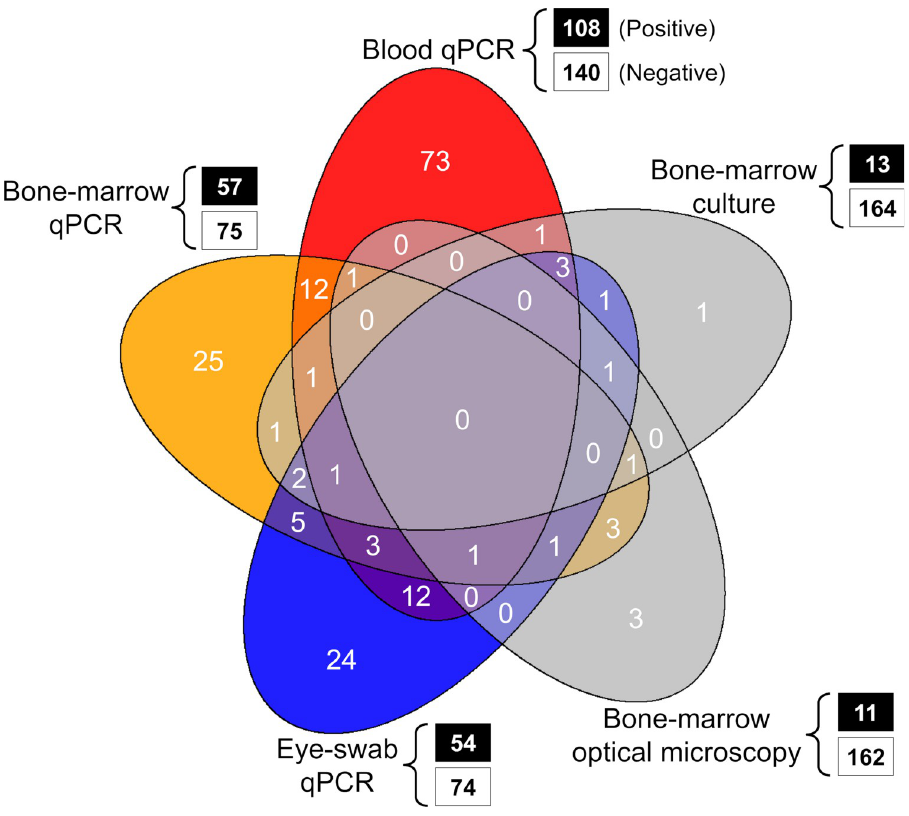
Fig 2. Patterns of positivity and co-positivity across five diagnostic procedures (parasitological and molecular) used for the detection of Leishmania infection in 294 domestic dogs.